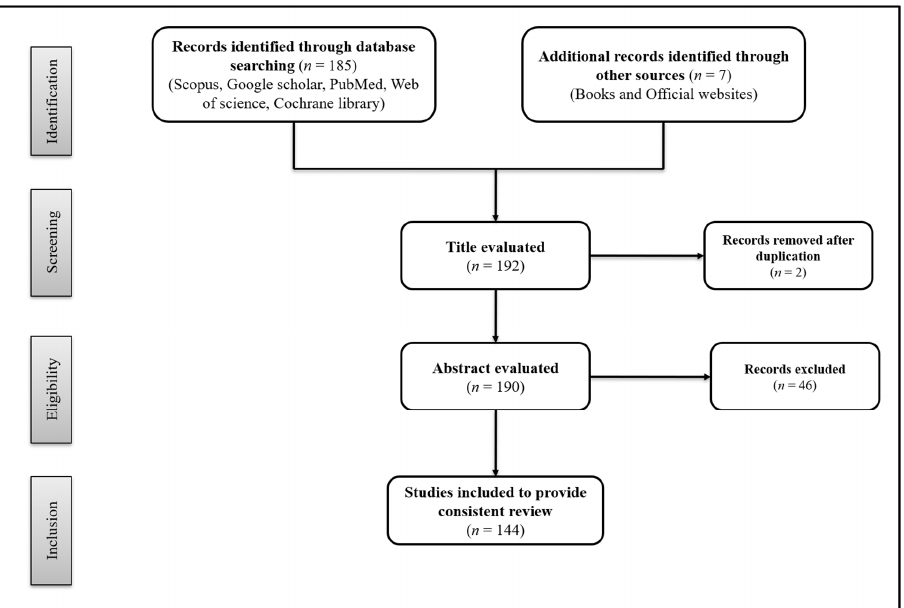
Figure 1. PRISMA flow diagram, showing the process of study selection.